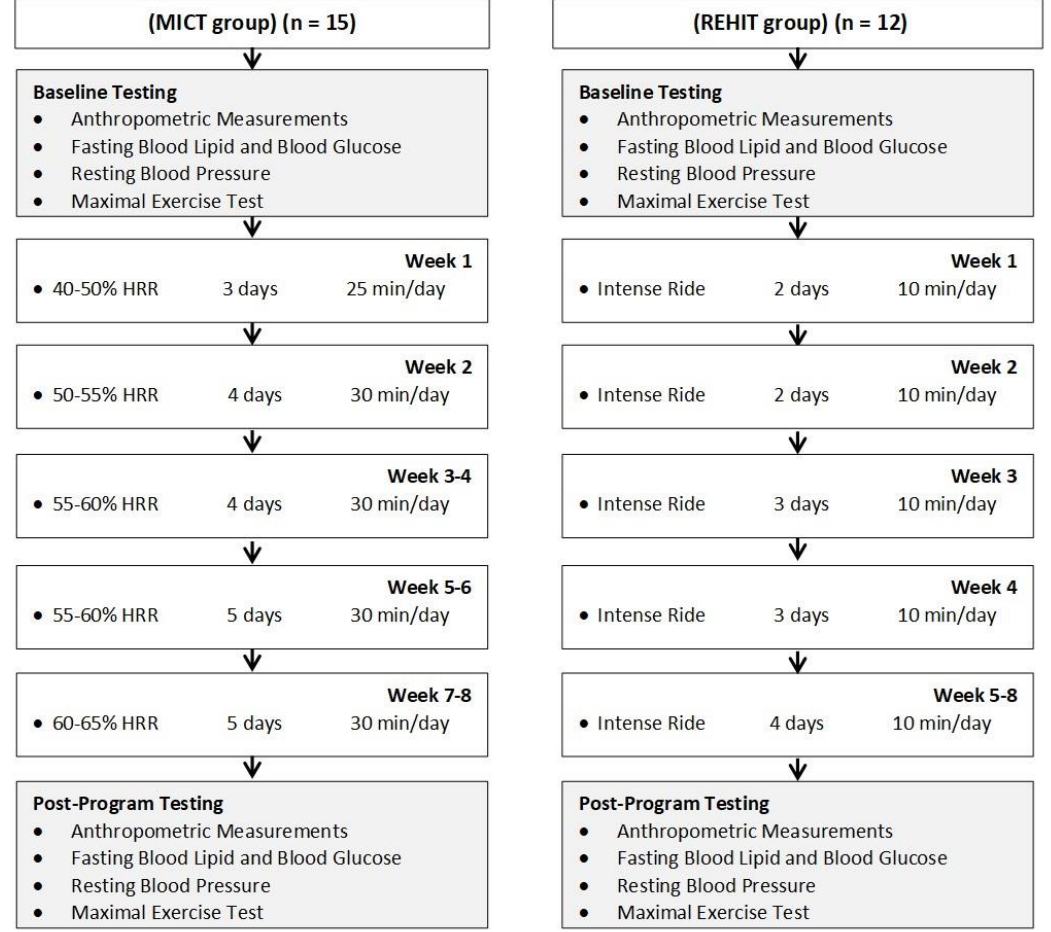
Figure 1. Experimental flow diagram and week-to-week exercise prescription for the days/times of training.